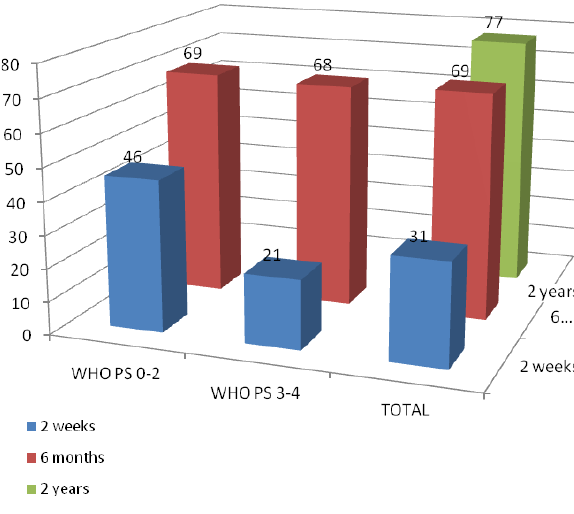
Figure 2 - Results based on ECOG – PS Eastern Cooperative Oncology Group performance status (therefore the External beam radiotherapy scheme was used). The rate of relapse is shown in blue, green and